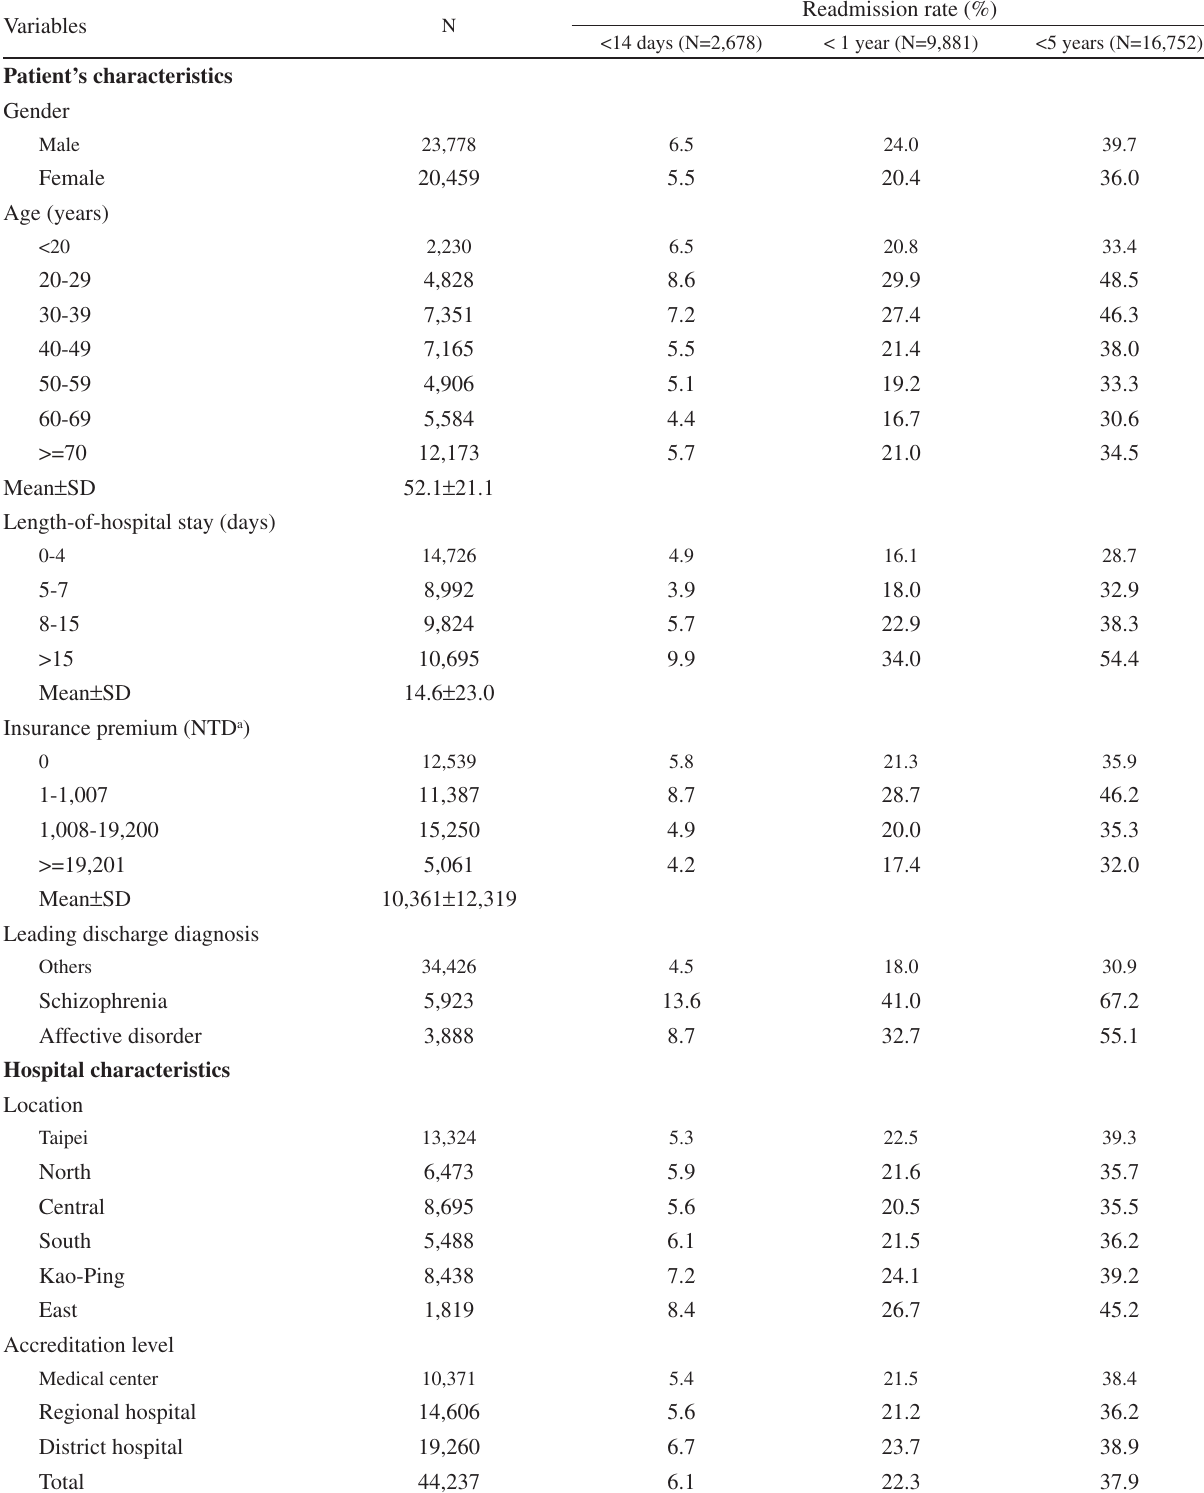
Table 1 - Readmission rates within various time periods after discharge according to the characteristics of patients and hospitals (n =